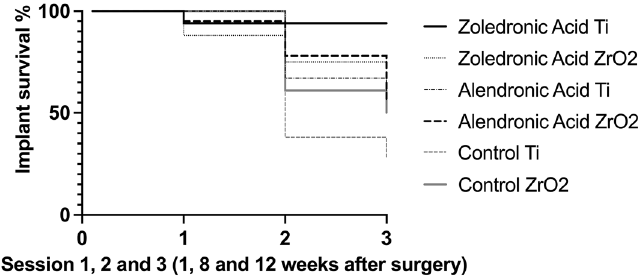
Figure 4. Presentation of the survival chart regarding all groups and implant materials (Ti = titanium, ZrO2 = zirconia).